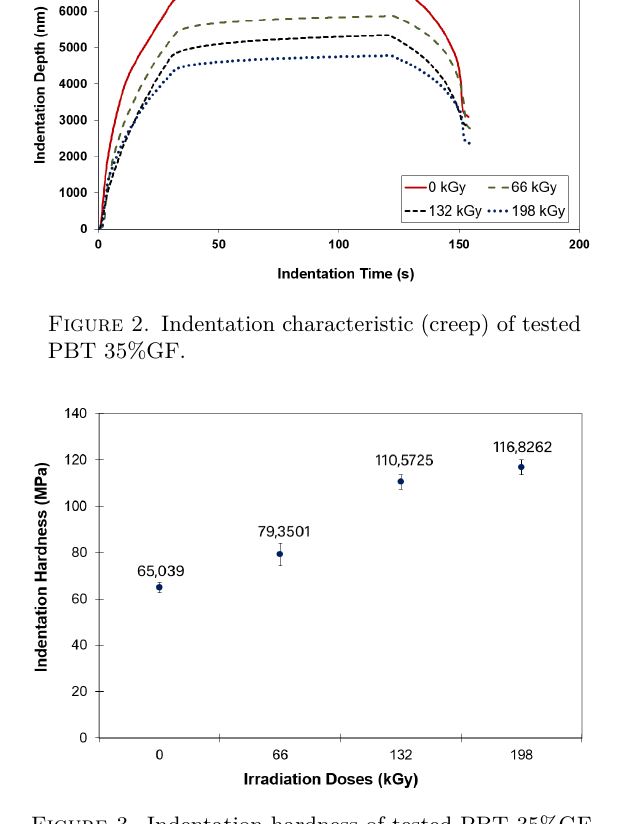
Figure 5. Indentation creep of tested PBT